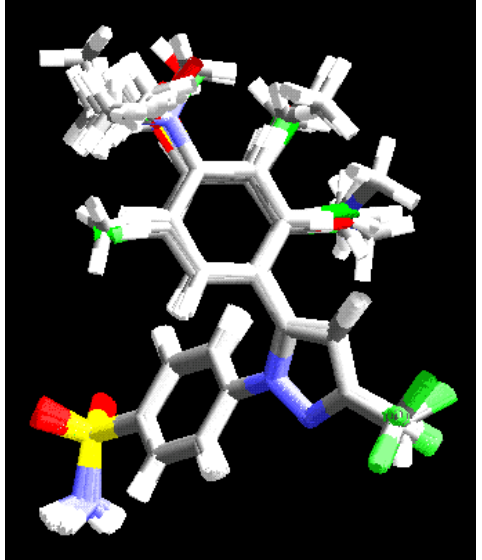
Figure 3. Molecular alignment (Cerius 2 ) based on Fragment 1. Note the very similar molecular super- positions in both Figures 1 and 3. Still, some subtle differences may be